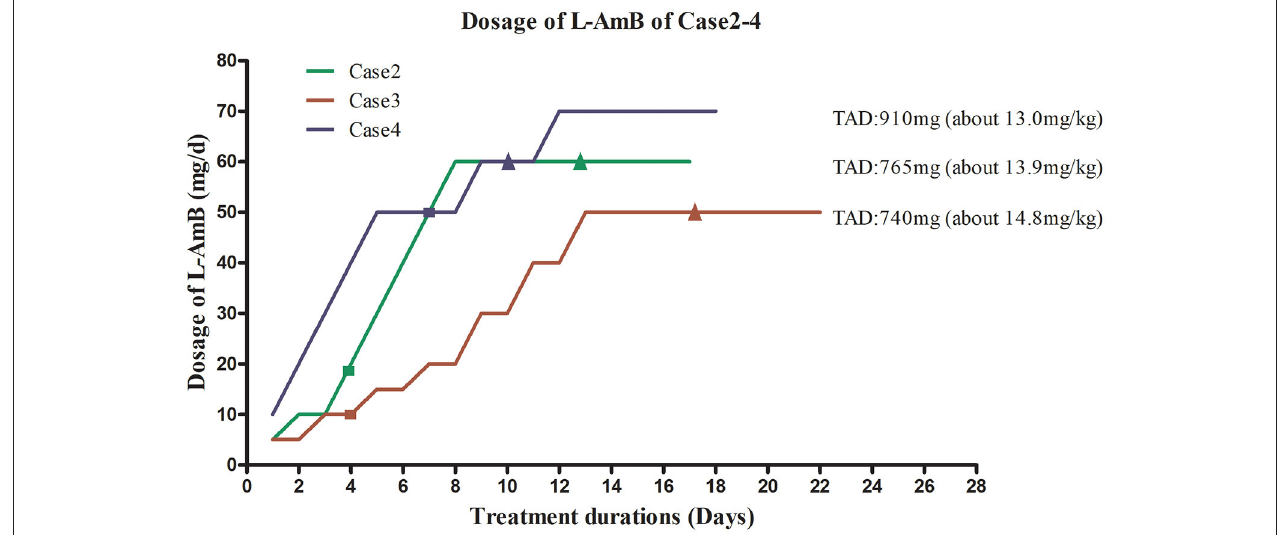
FIGURE 3 | Liposomal amphotericin B (L-AmB) administration protocol and temperature changes in Cases 2–4. TAD, total accumulated dosage. (cid:4) Normalization of body temperature. N Negative PCR result for bone marrow aspirate. To avoid complications associated with adverse drug reactions, the dosing regimens of L-AmB in case 2–4 were similar to those used for case 1, starting with a low dose that was gradually increased until the maximum tolerated dose was reached. This dosage was used for maintenance therapy. The initial dose for case 2 was 5mg ( ∼ 0.1 mg/kg) on day 1. The dose was increased to 10mg on day 2–3, and no complications occurred. Therefore, the patient received L-AmB in 10mg dose increments up to a dose of 60mg ( ∼ 1.2 mg/kg) on day 8. This dosage (60mg) was used for maintenance therapy until the cumulative dose of L-AmB reached 765mg (13.9 mg/kg) on day 17. Her body temperature returned to normal on day 4.